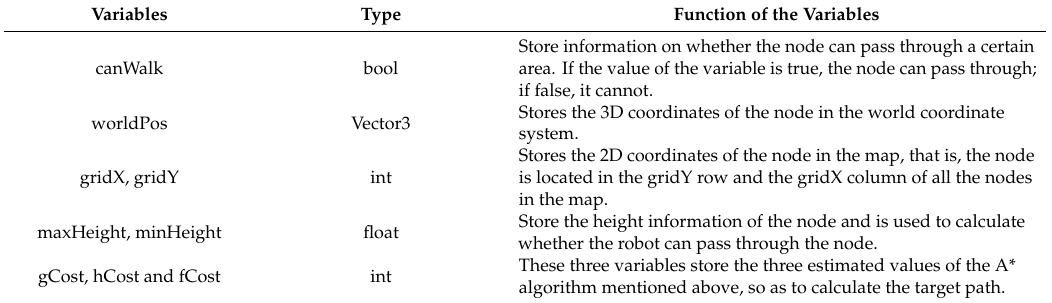
Table 6. Definitions of variables of data members from the class Node.